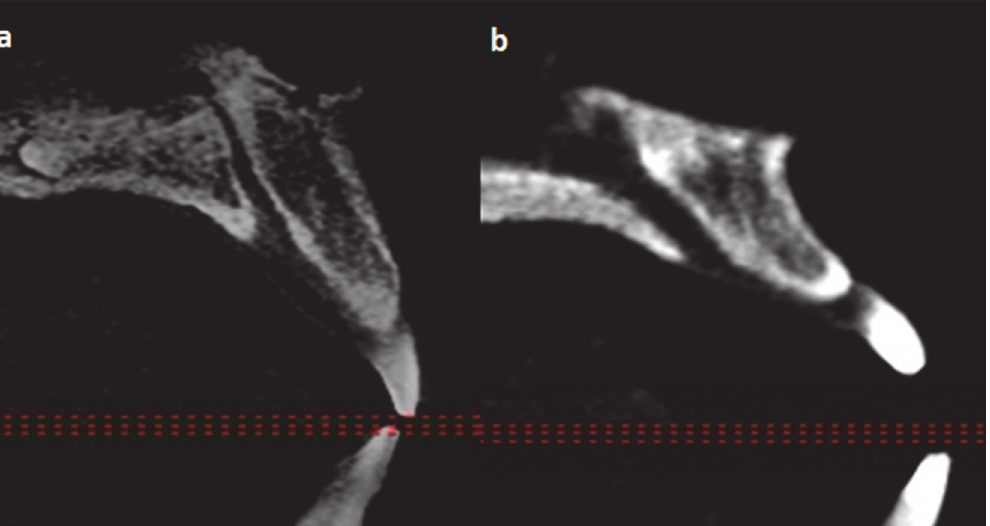
Fig 5. Sagittal view shows the typical appearance of a (a) flat and (b) concave alveolar maxillary bone labial to the incisive